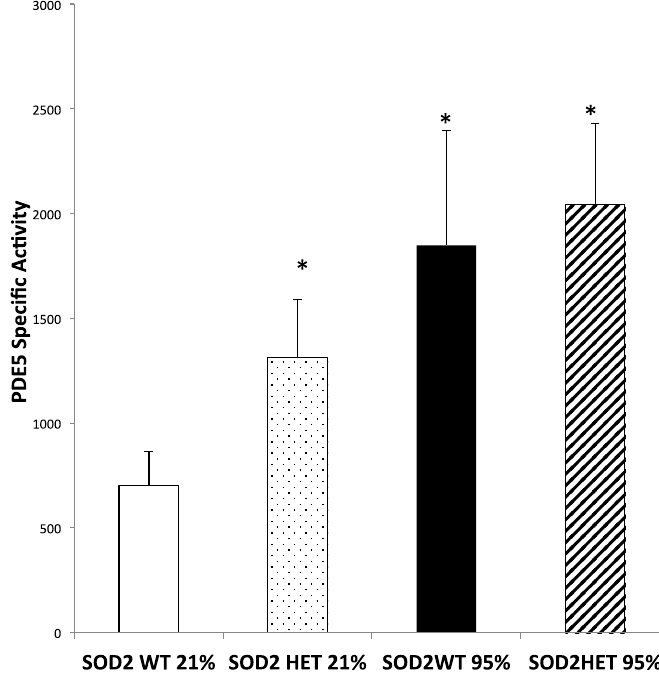
Figure 4. SOD2−/+ PASMC have increased phosphodiesterase 5 (PDE5) activity at baseline. PASMC were isolated from both SOD2−/+ (HET) and SOD2+/+ (WT) mice. PASMC were exposed to hyperoxia (95% O 2 ) for 24 h. PDE5 activity was measured in PASMC lysates using a commercially available assay, and results are reported as pmol cGMP hydrolyzed/mg/minute ( n = 7 (WT 21% O 2 ), 5 (HET 21% O 2 ), 4 (WT 95% O 2 ), 7 (HET 95% O 2 ); * p < 0.05 vs. WT 21% O 2 ). Data are shown as mean ± SEM. 2.5. SOD2−/+ Mice Develop Equivalent Lung and Vascular Disease in Chronic Hyperoxia (CH) Relative to SOD2+/+